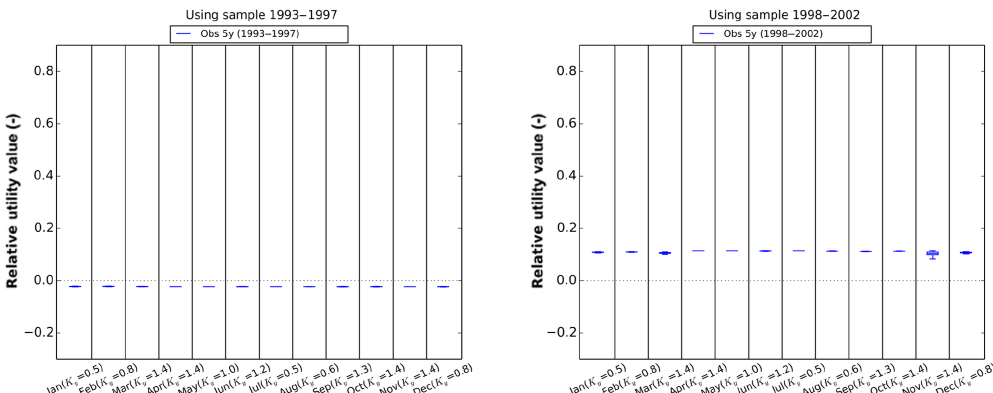
Figure 9. Relative utility value using an observed river discharge of 5 years for water scarcity happening independently in any one month. K y is the sensitivity of the crop to water deficit. Boxplots show the median, interquartile range and minimum–maximum range.